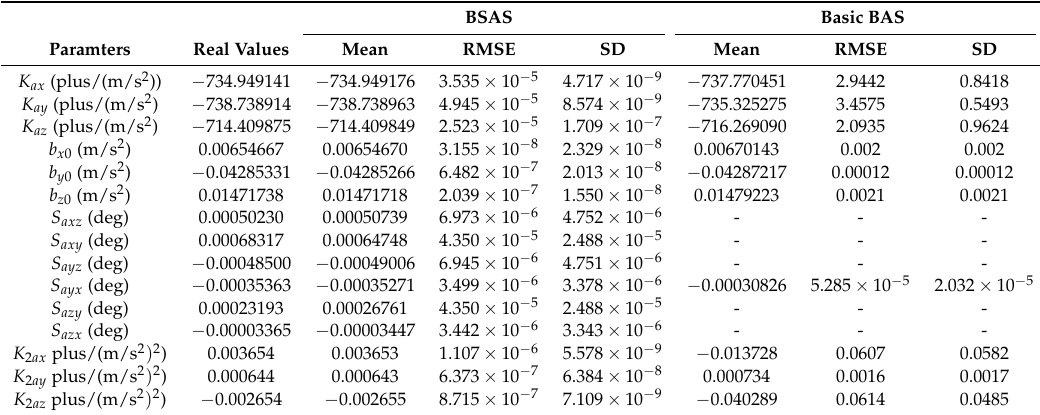
Table 3. 50 simulation results of 15 calibration parameters.